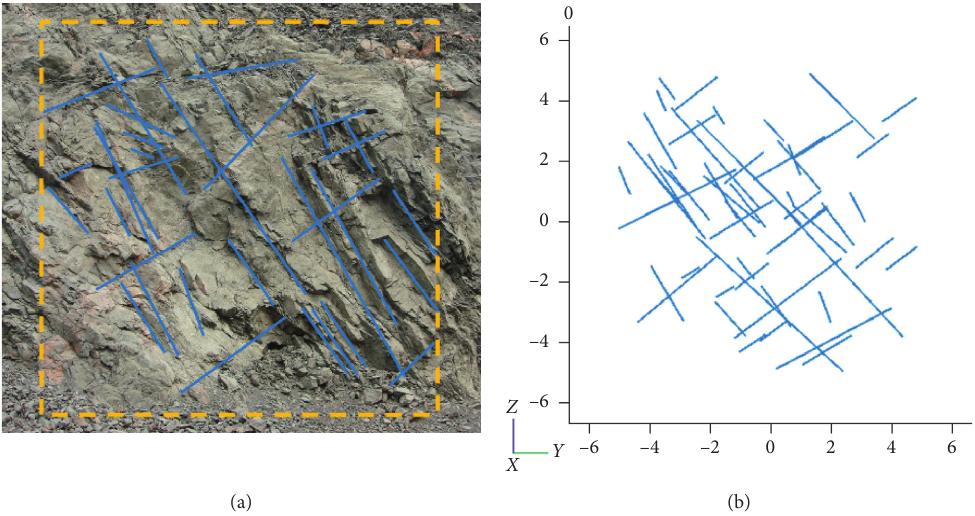
Figure 7: Comparison and verification of joints: (a) actual joints; (b) simulation joints.